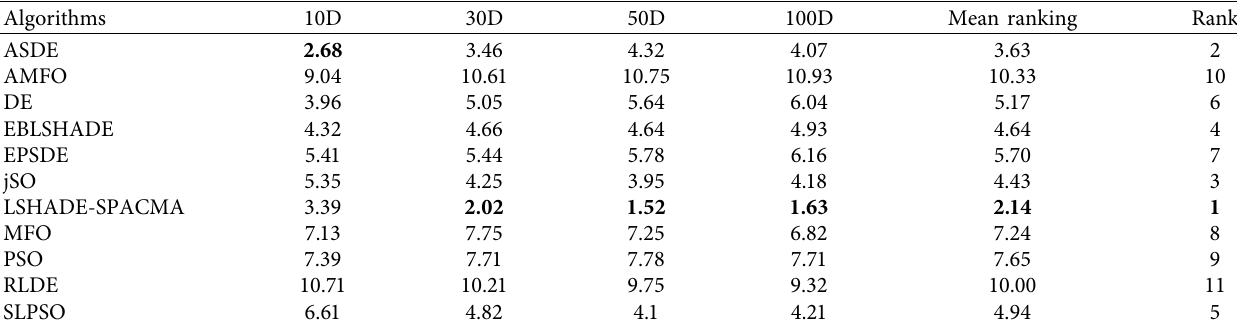
Table 2: Average ranks for all algorithms across 28 problems and all dimensions using CEC2017.